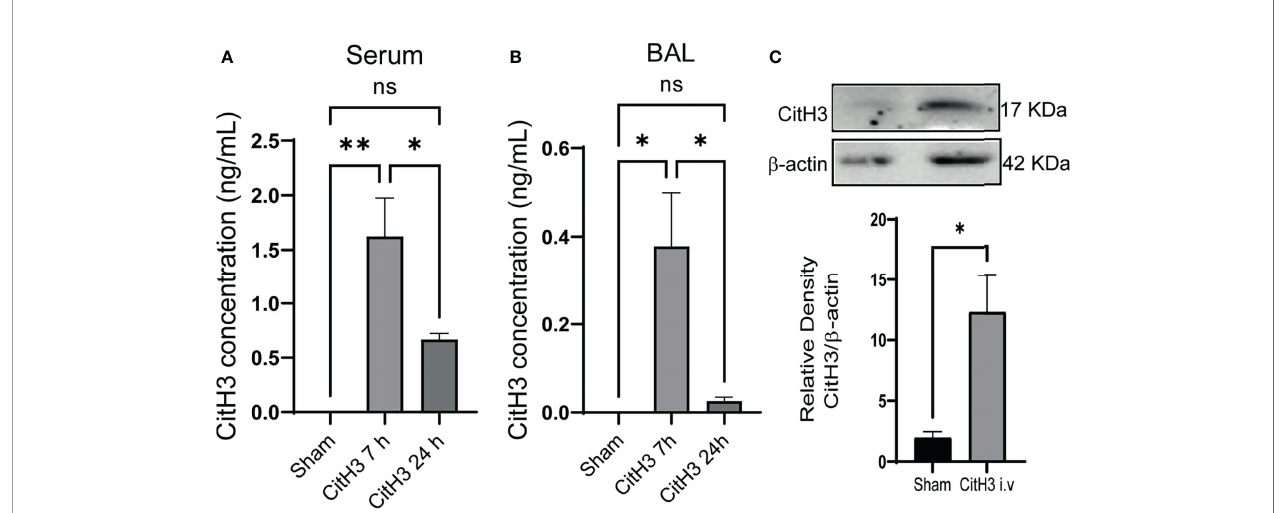
FIGURE 2 | Intravenous injection of Cith3 in mouse induces its accumulation in lung tissue. Levels of CitH3 in (A) serum (n = 3, 4, 4 for each group) and (B) BALF (n = 3, 5, 5 for each group) in mouse after i.v. injection of CitH3 peptide at 0 h, 7 h and 24 h. (C) Representative Western blot images and densitometry quanti fi cation of expression of CitH3 protein in mouse lung tissue with or without CitH3 peptide challenging (n = 3/group) at 24 h. Data are expressed as mean ± SEM. *P < 0.05, **P < 0.01. i.v., intravenous; ns, not signi fi cant; SEM, standard error of the